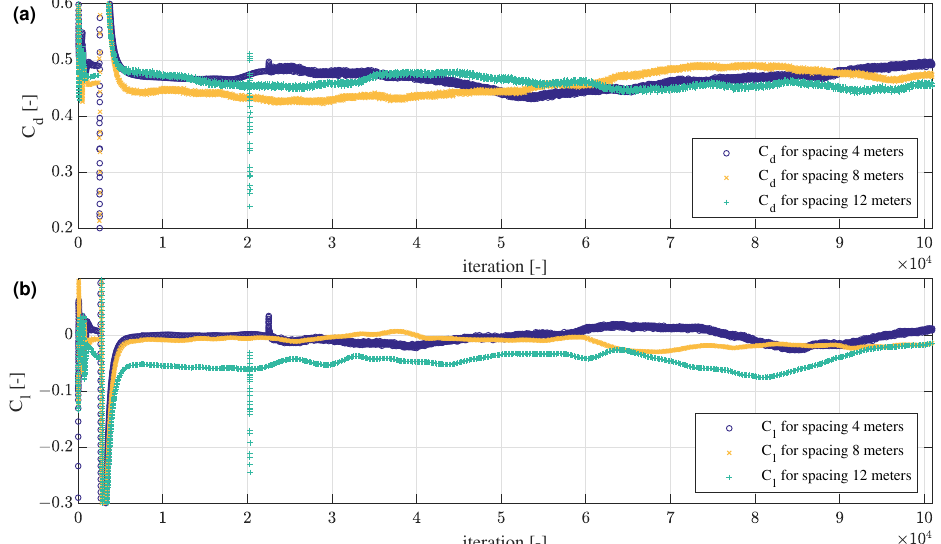
Figure 9. Comparison of the aerodynamic coefficients for heterogeneous columns consisting of three vehicles: van–truck–car. The graph shows the data for the second vehicle: truck. For the marker: dark blue “o”—the distance between the vehicles is 4 m, orange “ × ”—the distance between the vehicles is 8 m, teal “+”—the distance between the vehicles is 12 m. ( a ) Drag coefficient. ( b ) Lift